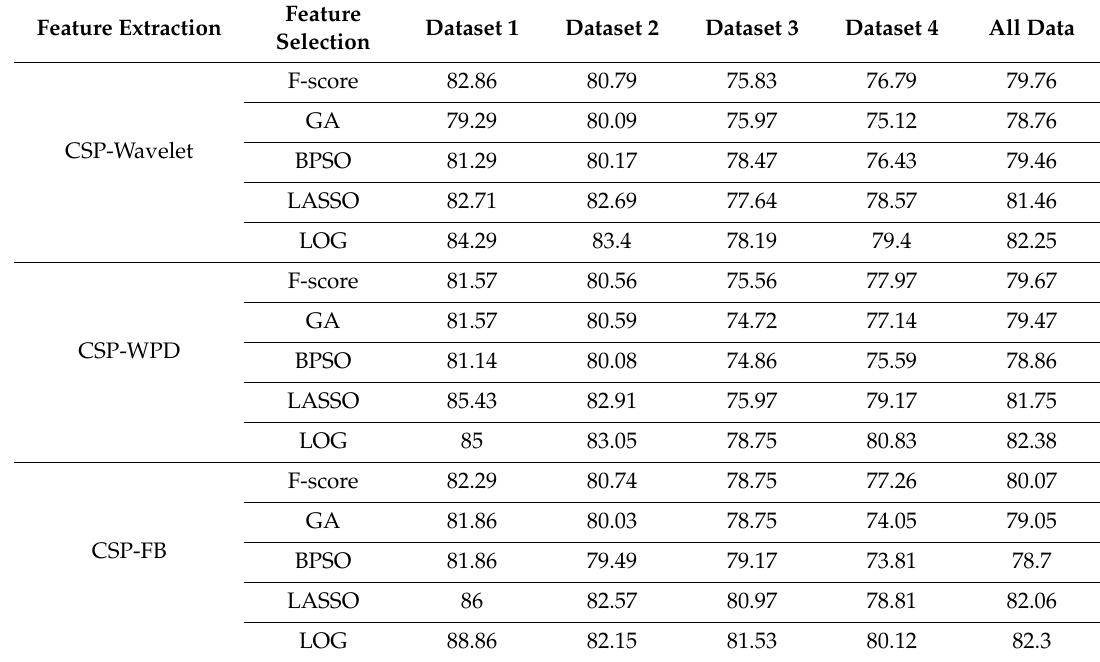
Table 8. The e ff ect of di ff erent feature selection methods on average classification accuracy of various datasets. Feature Extraction